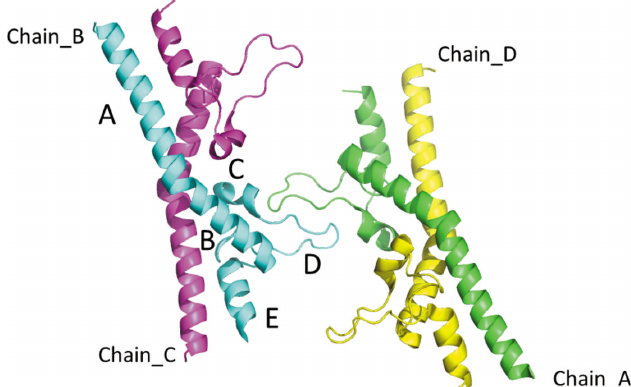
Figure 1 Asymmetric unit of the twinned CD9 EC2 crystal, coloured by protein chain. Domains are labelled A – E in the cyan-coloured chain. The D loop is flexible as follows from comparison of different structures involving CD9 EC2 and structures of EC2 domains from other tetraspanins (Oosterheert et al. , 2020). The direction of view is approximately along the non-crystallographic (NCS) twofold axis that coincides with the twofold twin axis a* + b* (see text). The NCS operation transforms chain A into chain B , and chain C into chain D .